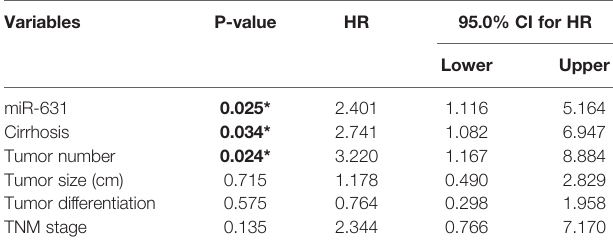
TABLE 3 | Multivariate analysis of individual prognostic